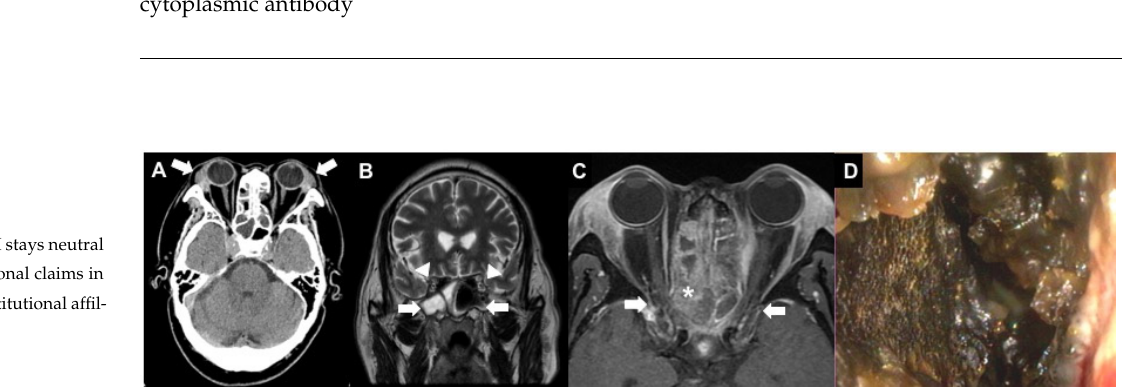
Figure 1. A 63-year-old male farmer presented to the emergency department with severe headache, nasal obstruction, and blurred vision for one month. Ocular examination showed bilateral periorbital edema and swelling of the lacrimal gland. The corrected visual acuity (CVA) was 20/40 in the right eye and 20/200 in the left eye. There was no limitation in all directions of extraocular movements. No relative afferent pupillary defect (RAPD) sign was detected. Non-contrast brain computerized tomography (CT) revealed enlarged lacrimal glands ( A , arrows) and opacification in paranasal sinuses ( B , arrows) without optic canal compression ( B , arrowheads) in the orbital magnetic resonance imaging (MRI). He received systemic intravenous antibiotics for sinusitis. However, three days later, the patient’s vision deteriorated to only light sensation with a positive RAPD sign